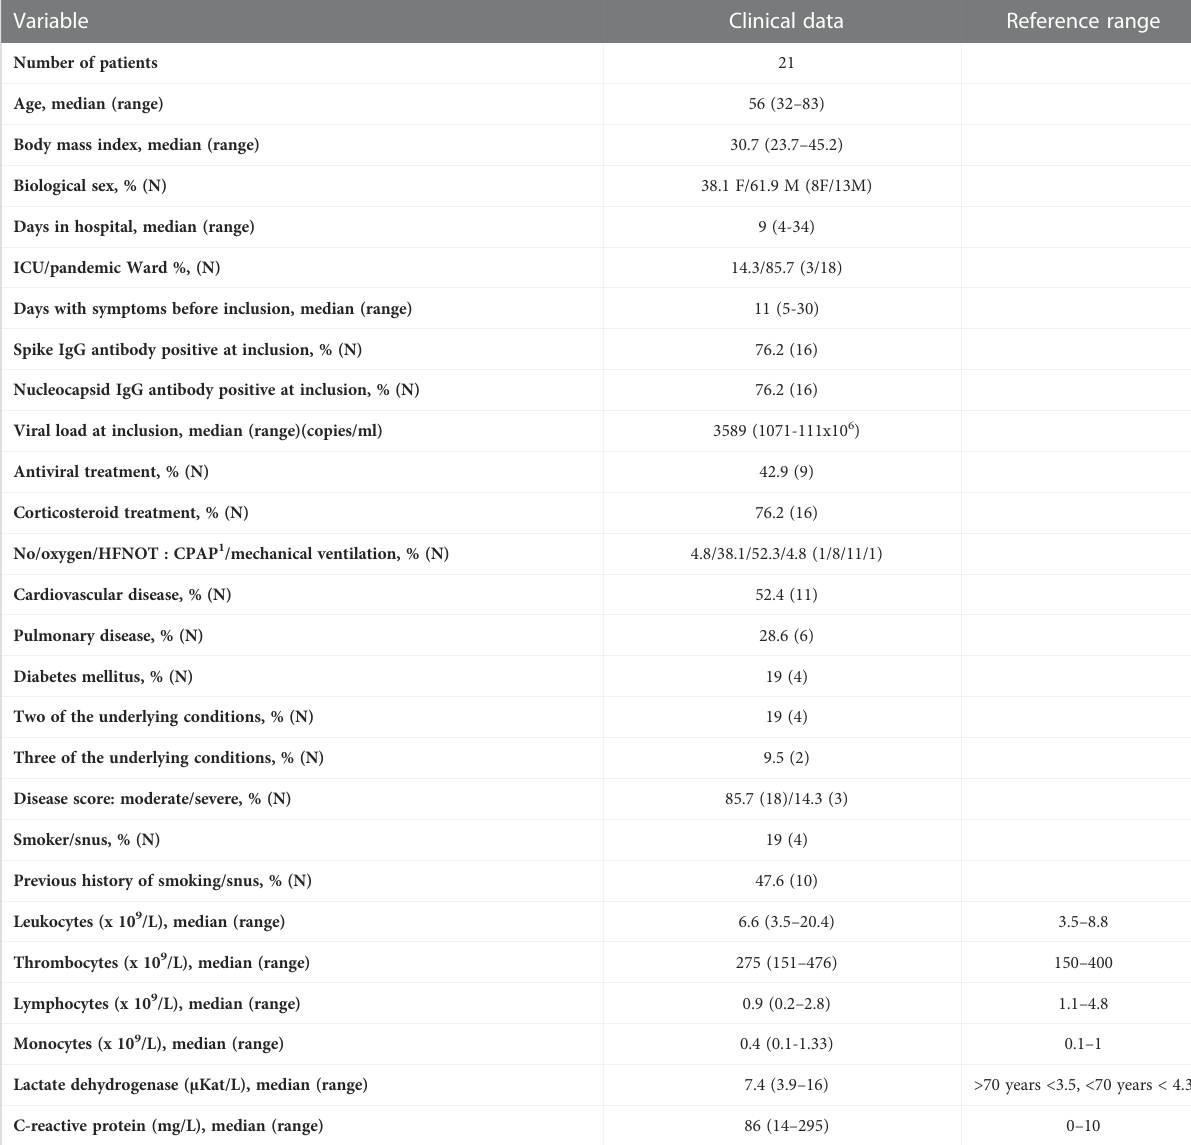
TABLE 1 Clinical and-demographical characteristics of hospitalized COVID-19